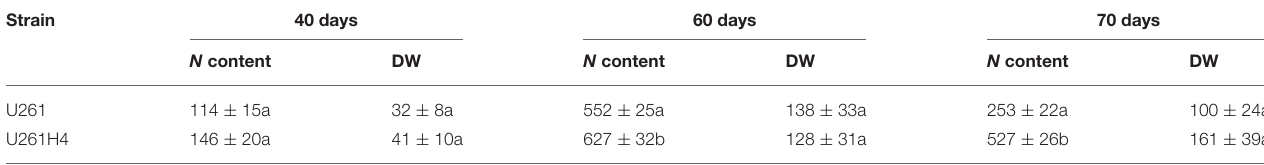
TABLE 3 | Effect of the introduction of hup genes on symbiotic performance of M. loti U261 in association with L. corniculatus plants. Strain 40 days